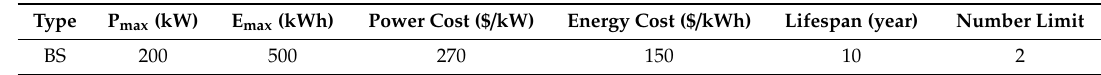
Table 2. Technical Parameters of BSs.